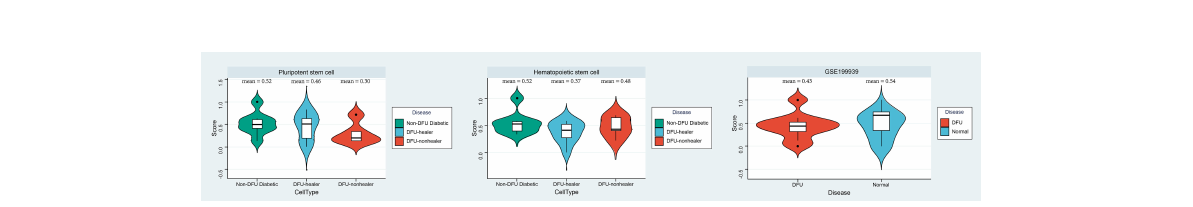
FIGURE 6 Index analysis of diabetic podocyte stem cells. Using the OCLR algorithm, the dricity of hematopoietic and pluripotent stem cells in DFU healing and non-healing as well as diabetic patients was assessed, and Violin diagram showing the differences between disease groups (left and middle). Furthermore, GSE199939 Validated the dricity between the DFU and Normal tissue (right). Score, dry